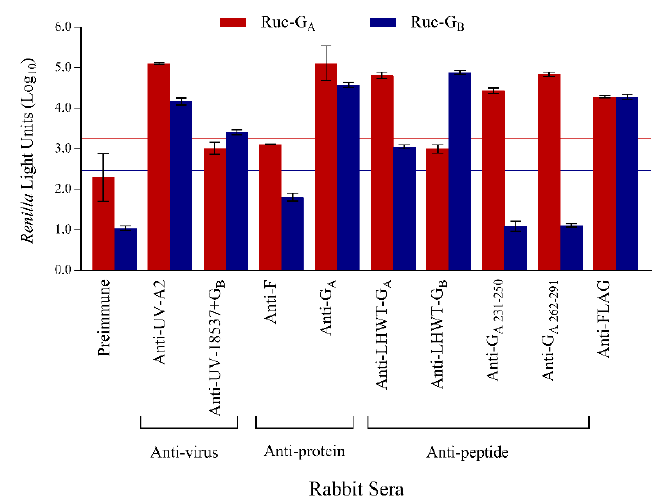
Figure 3. Specificity of the LIPS-G assays. Specificity of RSV LIPS-G assays was also shown using rabbit antisera. Mean reactivities against Ruc-G A and Ruc-G B antigens are shown in red and blue bars, respectively, and error bars represent standard deviations. Data were normalized against rabbit anti-FLAG antibody. Cutoff values for a positive signal were five standard deviations above the mean value of the negative control and are shown as horizontal red (Ruc-G A ) and blue lines (Ruc-G B ).